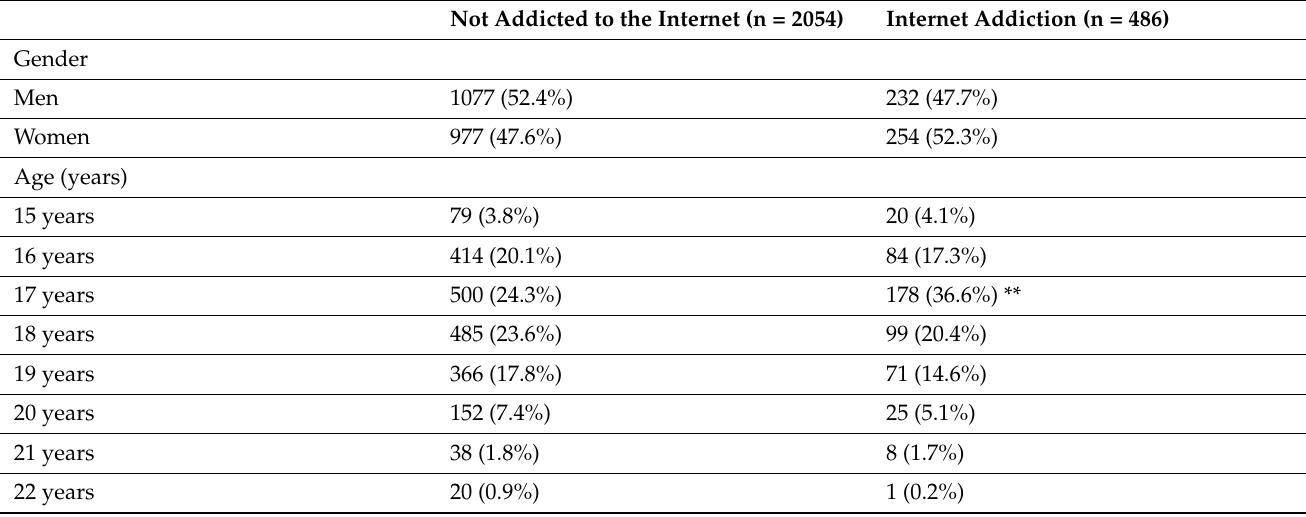
Table 4. Comparison of baseline characteristics of the study